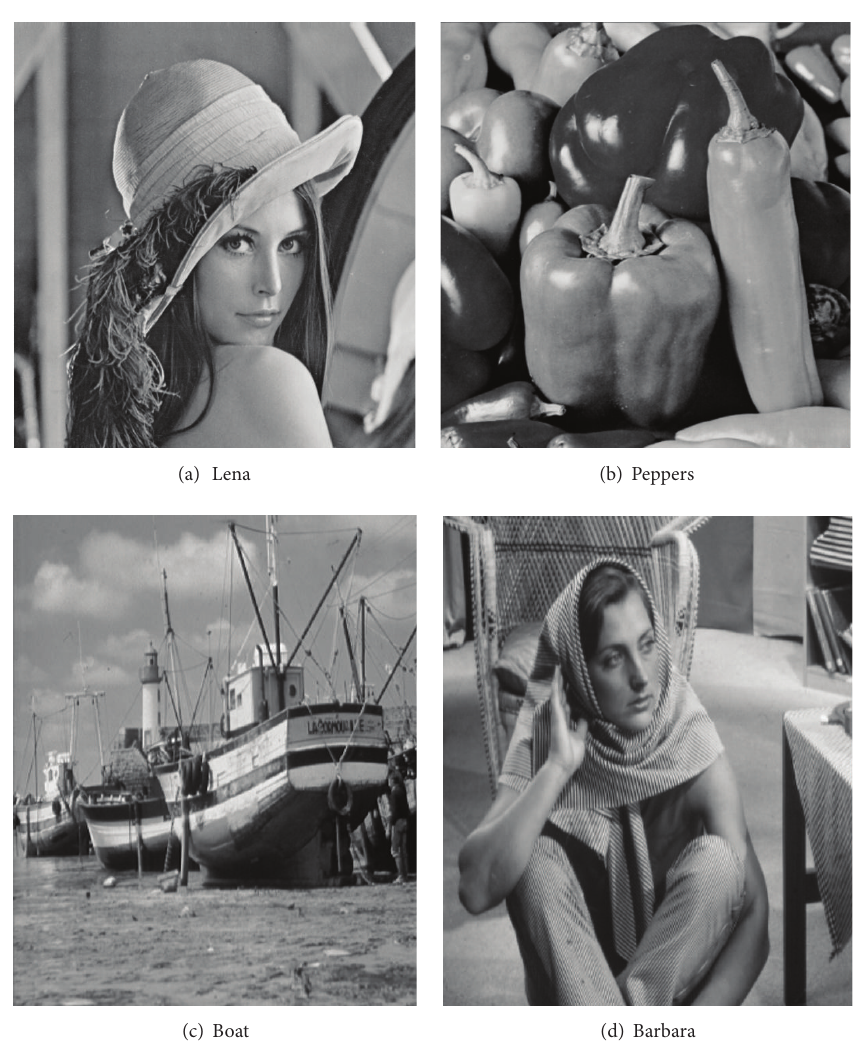
Figure 2: Sample standard images used for